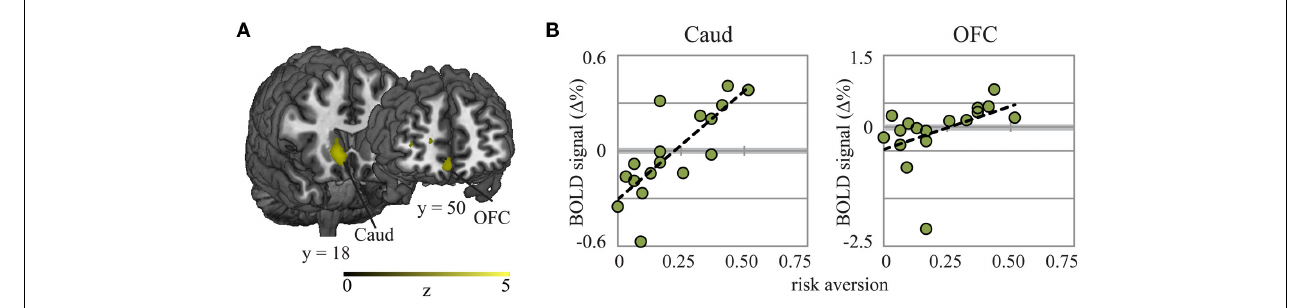
(A) Activation maps and (B) scatterplots showing the relationship between BOLD signal and risk aversion. Coordinates in MNI space; Caud, caudate nucleus; OFC, orbitofrontal